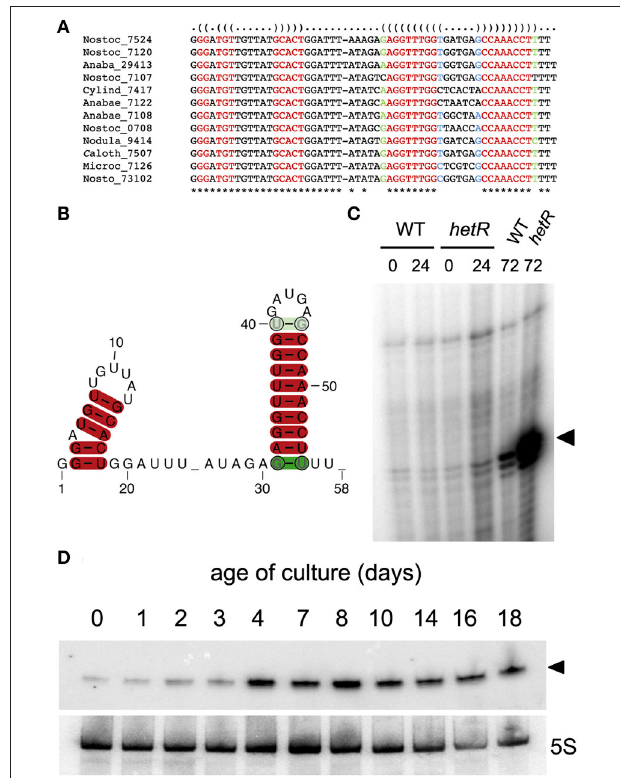
FIGURE 4 | Predicted sRNA transcribed from position 4547237r in Nostoc sp. PCC 7120. (A) Alignment of homologs found in the genomes of heterocystous cyanobacteria. The identifiers for the genomes are described in Table S2. (B) Consensus secondary structure prediction by RNAalifold ( Bernhart et al., 2008). (C) Primer extension of RNA samples from the wild type Nostoc sp. PCC7120 (WT) and the hetR mutant subjected to combined nitrogen deficiency for the number of hours indicated. Extension products corresponding to position 4547237r are indicated with a black triangle. (D) Northern blot showing increased expression of the predicted sRNA (indicated with a black triangle) with density of the cultures. Lower panel shows hybridization to a 5S